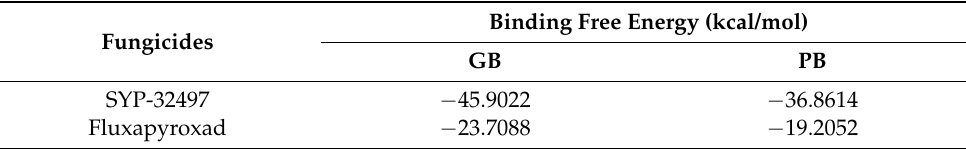
Table 2. The binding free energy of SYP-32497 and fluxapyroxad with